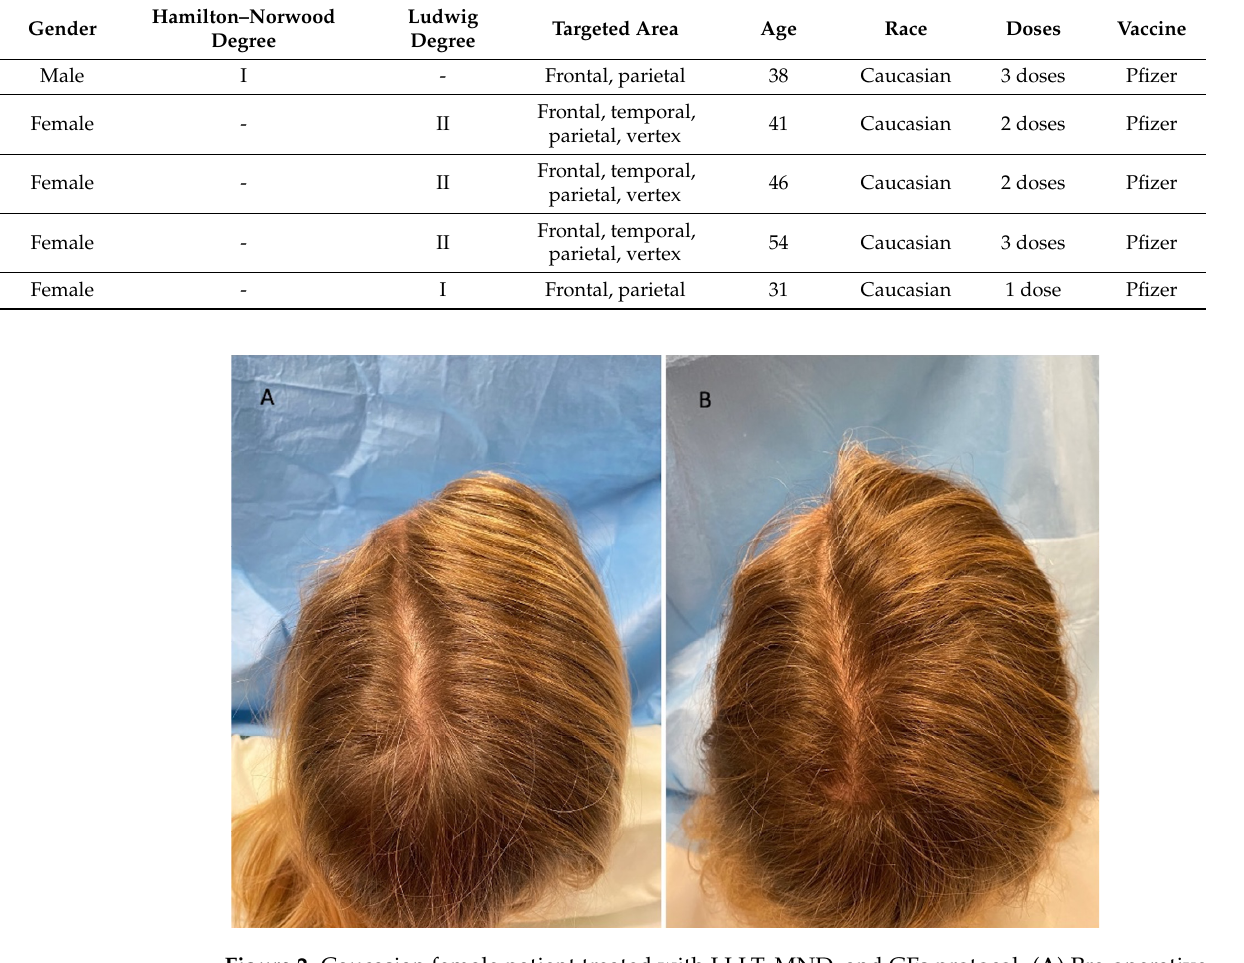
Figure 2. Caucasian female patient treated with LLLT, MND, and GFs protocol. ( A ) Pre-operative view of the scalp of a 41 year-old female patient affected by AGA of II degree according to the Ludwig scale and several episodes of TE during the pandemic period and in particular 1 month after the COVID-19 positivity, with hair loss localized in the frontal, temporal, and parietal areas; ( B ) post-operative view at T1 (20 wks) after treatment with detail of HR-G in the parietal area.